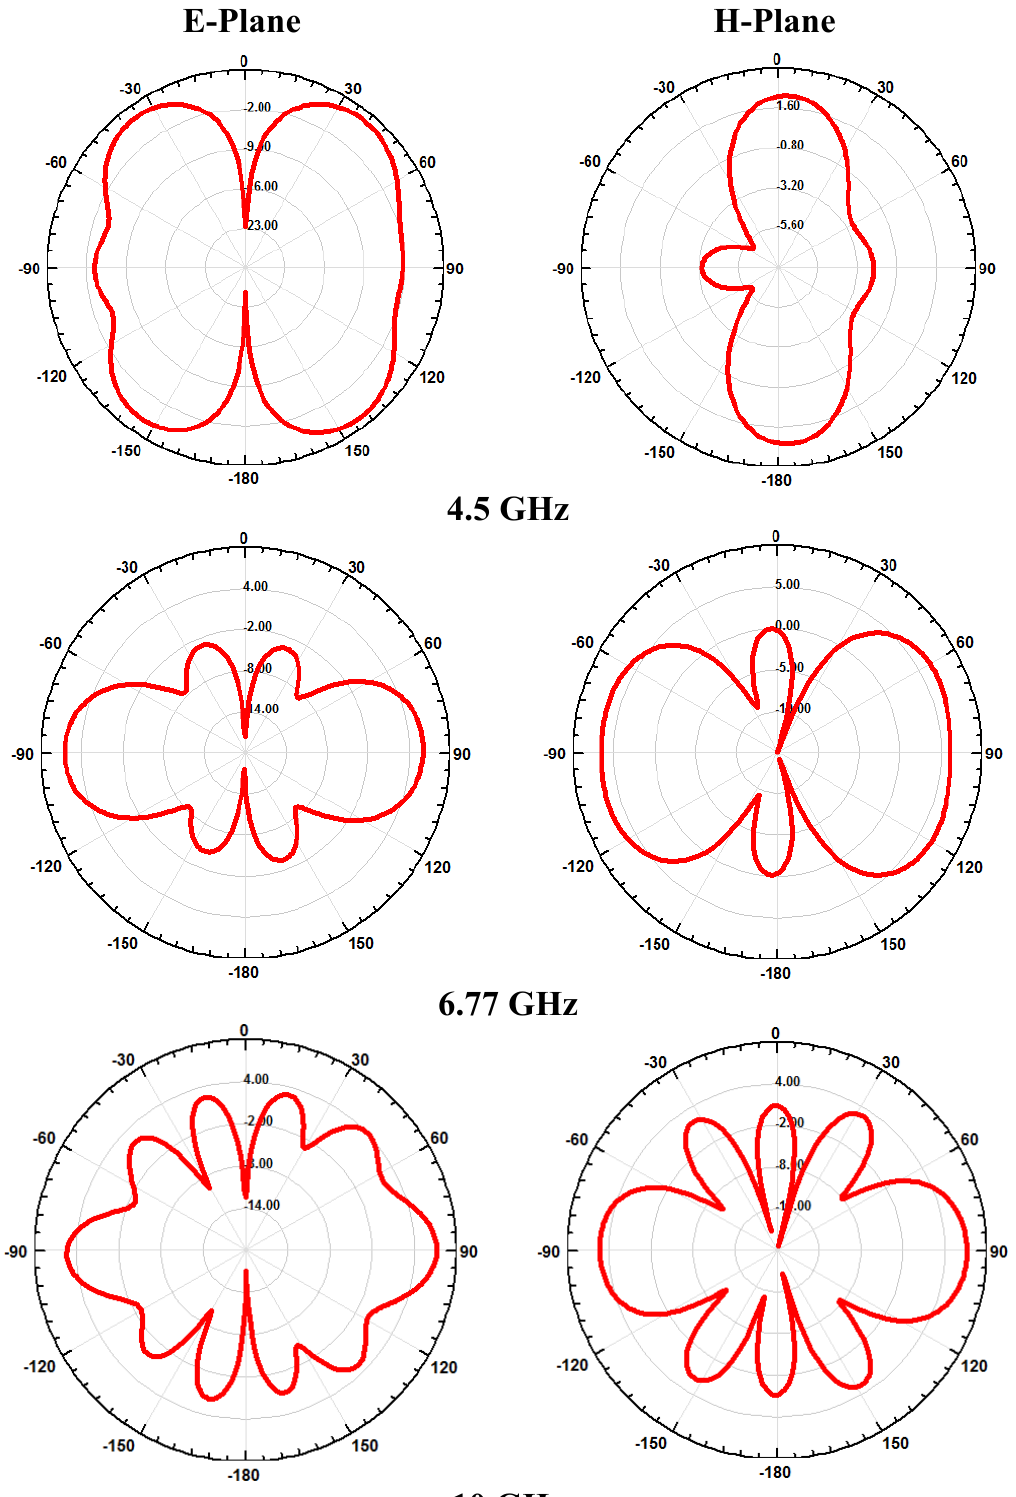
Figure 9: Simulated radiation patterns for the proposed antenna for the two principal planes (E-plane & H-plane), at three different operating